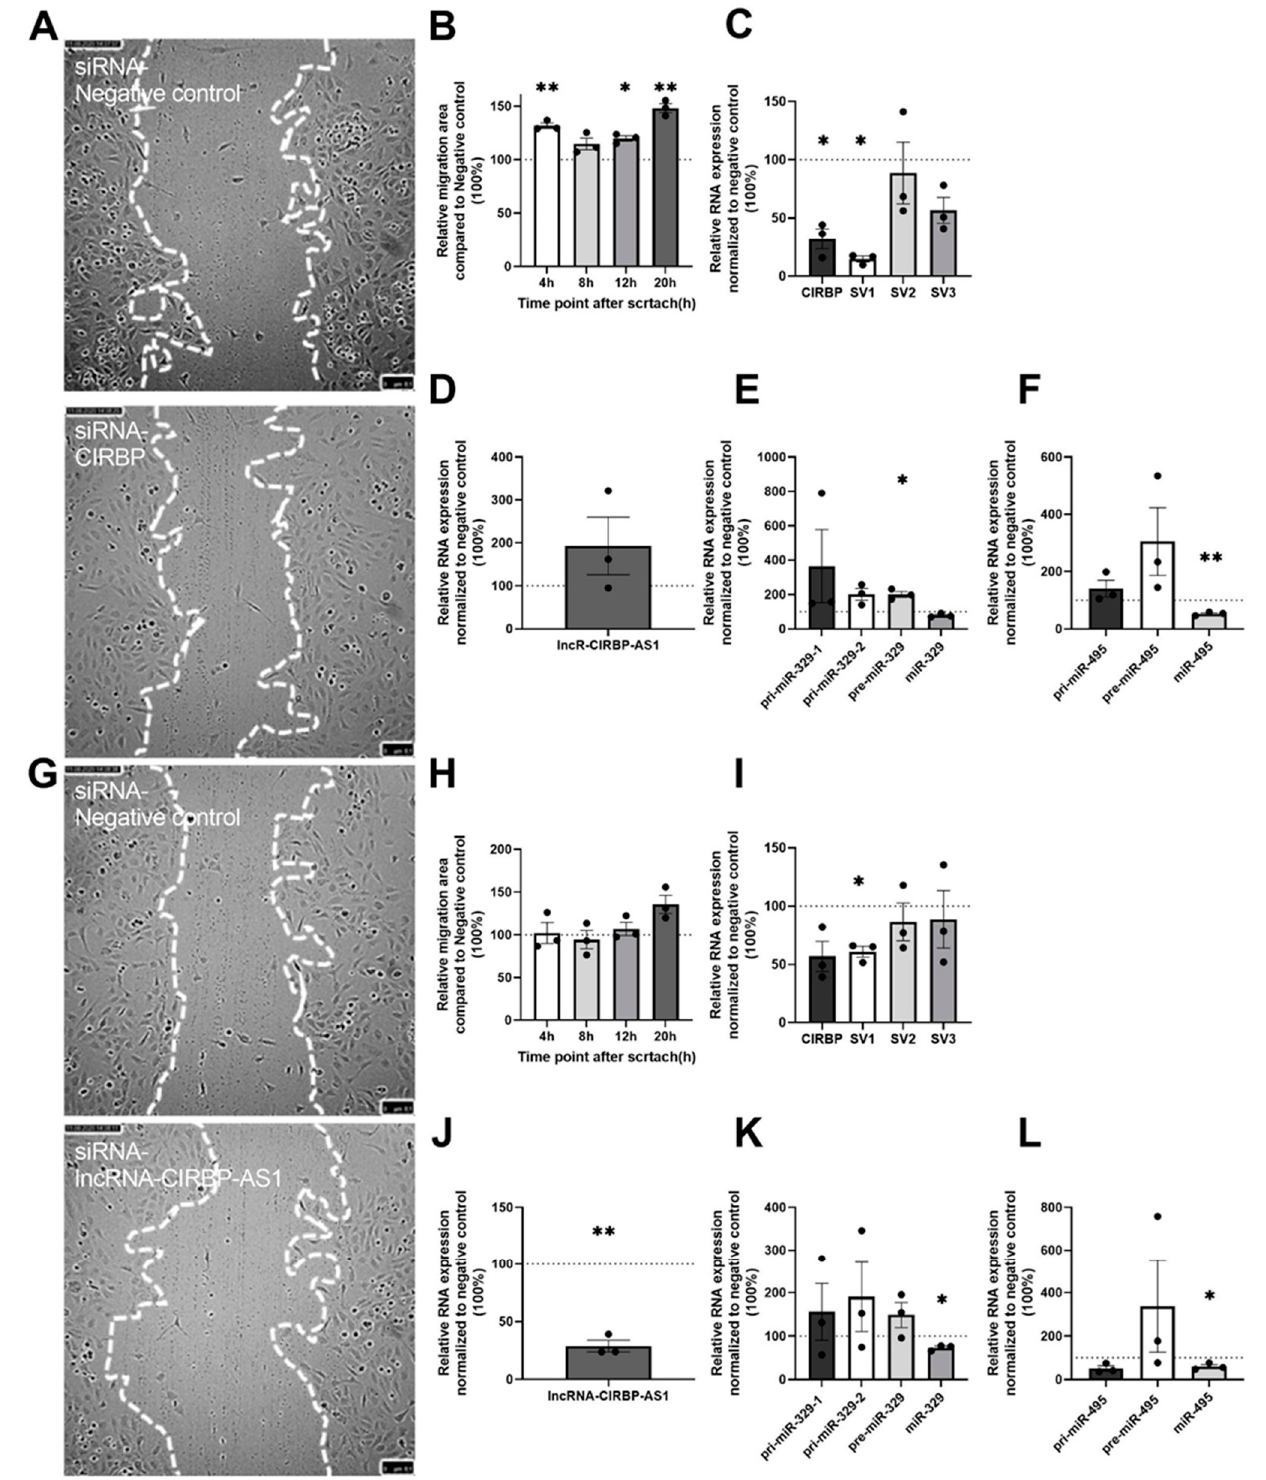
Figure 7. Four-hour transfection of siRNA on HUVECs: ( A ) Representative image of wound healing ( n = 3) at 20 h after scratch on HUVECs, and ( B ) quantification of the migration area at different timepoints, treated over 4 h with siRNA targeted to CIRBP and the negative control. White, dotted lines mark the edge of the HUVECs’ layer. ( C ) Total CIRBP expression and its splice variant expressions after the scratch assay, normalized to GAPDH. ( D – F ) After the scratch assay, the pri-miRNA, pre-miRNA, and mature microRNA expression levels of miR-329 and miR-495 were measured and normalized to U6; lncRNA- CIRBP -AS1 were measured and normalized to GAPDH. ( G ) Representative image of wound healing ( n =